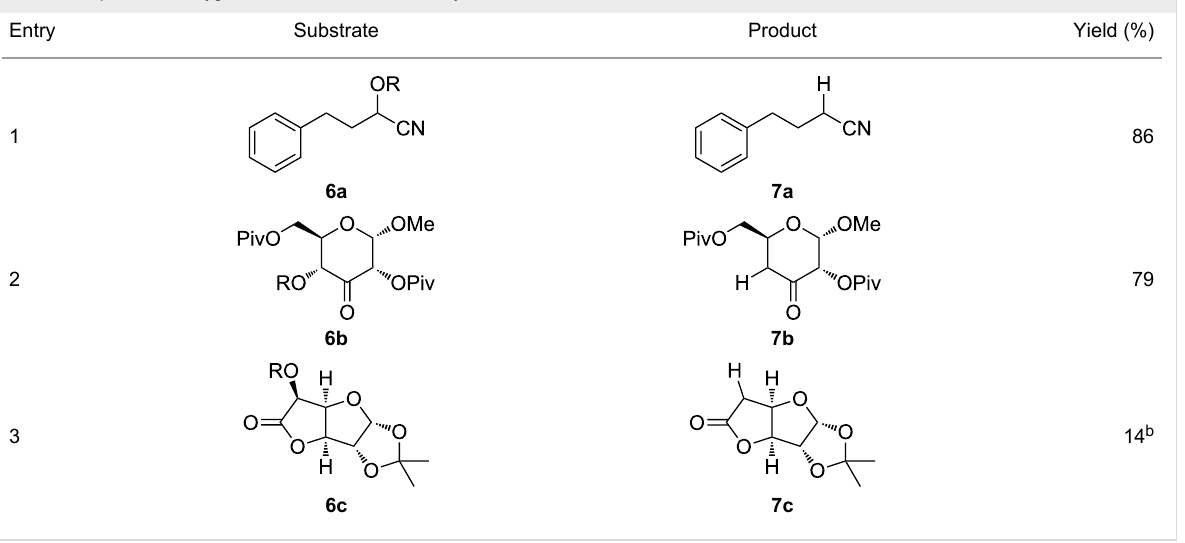
Table 4: Preparative deoxygenation reactions of non-benzylic benzoates. a